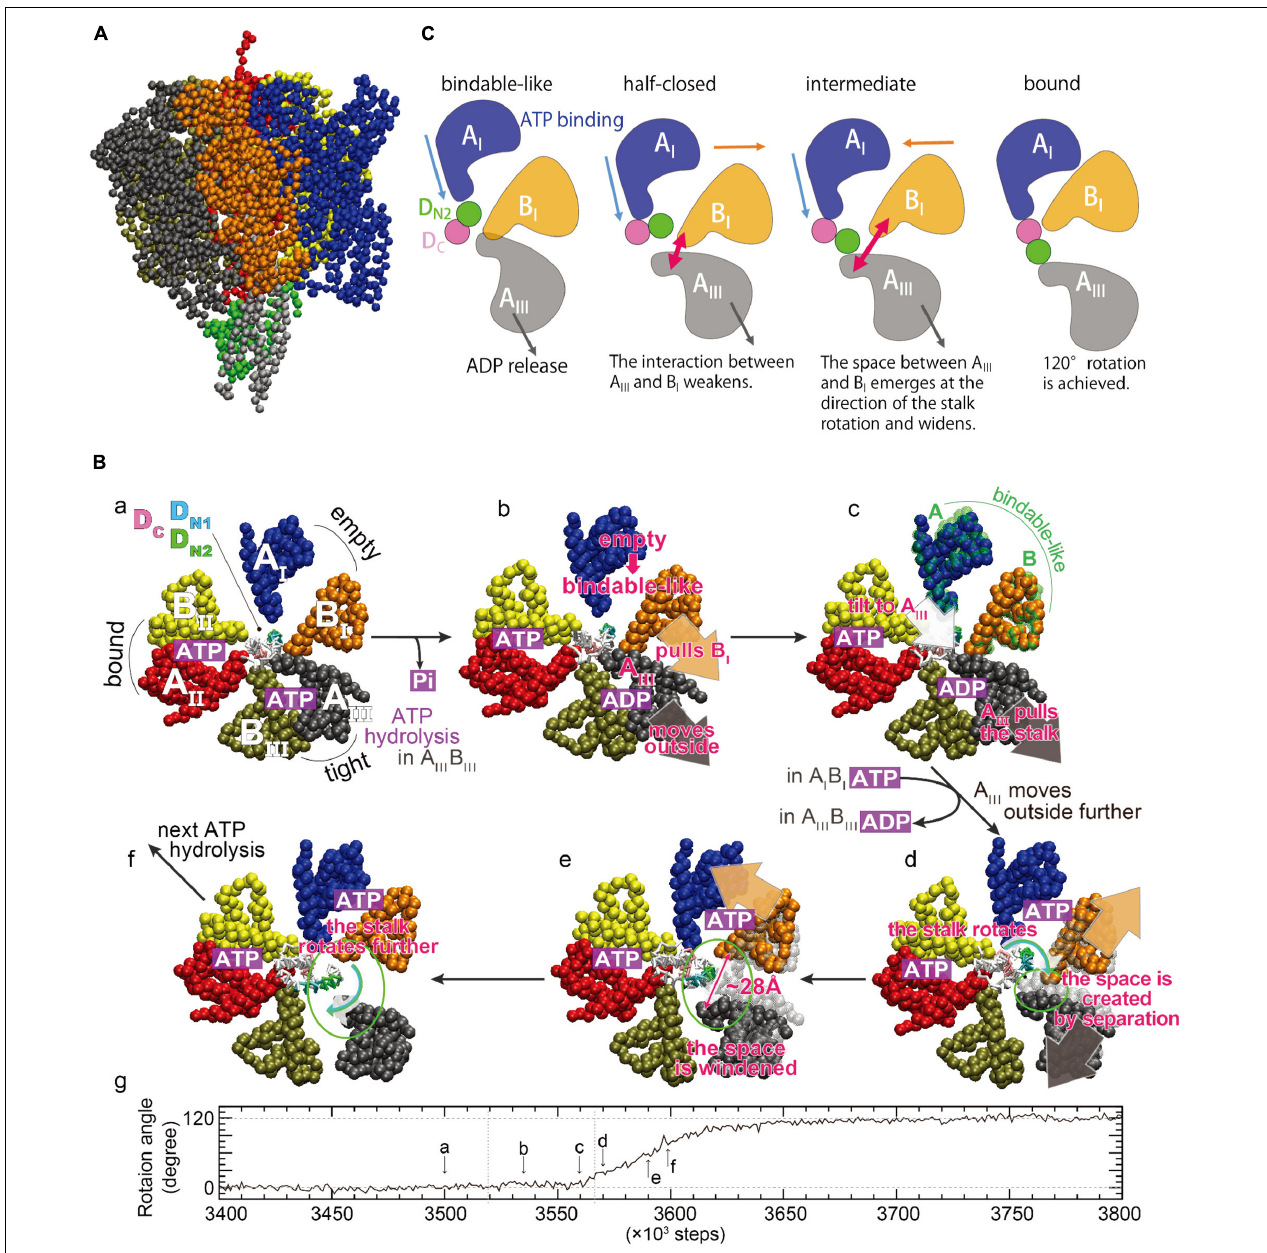
FIGURE 4 | Rotation mechanism proposed by multiscale molecular dynamics simulations. (A) A coarse-grained model of V 1 -ATPase. The color coding of each subunit in the A 3 B 3 ring is the same as that of (B) , sub-panel a. The central shaft is colored by gray (D subunit) and green (F subunit). (B) Time evolution of the rotation angle of the shaft and typical conformations in a simulation. The sub-letters a–f represent each snapshot, pointing in the direction of rotation angle progression (Isaka et al., 2017). The three AB subunits are denoted as A I B I (blue and orange), A II B II (red and yellow), and A III B III (black and tan), and are the same as A O B C , A C B O (cid:48) , and A CR B CR ( Figure 2 ) at the initial structure described in sub-panel a. The region of the shaft enclosed in the A 3 B 3 ring consists of two helices of the N- and C-terminus of the D subunit, denoted as D N and D C (magenta), respectively. D N is further decomposed into D N 1 (T20 – L29, cyan) and D N 2 (K30 – Q39, green). (C) A schematic picture of dynamical rearrangements of the AB subunits and the shaft (Ekimoto and Ikeguchi, 2018). The A I , B I , A III , D N 2 , and D C are the same as those in (B) . The unidirectional arrows show the movements of the subunits, and the bidirectional arrows show width of the space between A III and B I subunits